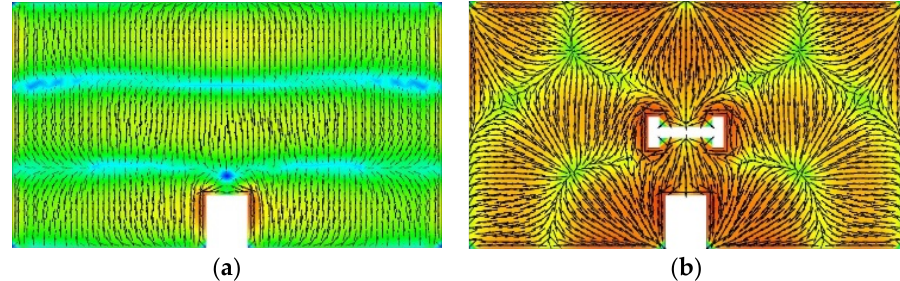
Figure 9. Current distribution of the TM02 mode. ( a ) Conventional patch antenna. ( b ) Proposed H-slot antenna.